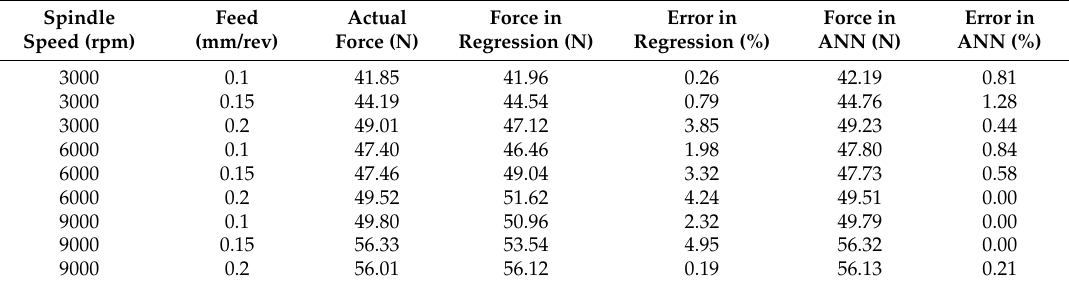
Table 9. Predicted cutting forces using regression model and ANN model for tool T2.